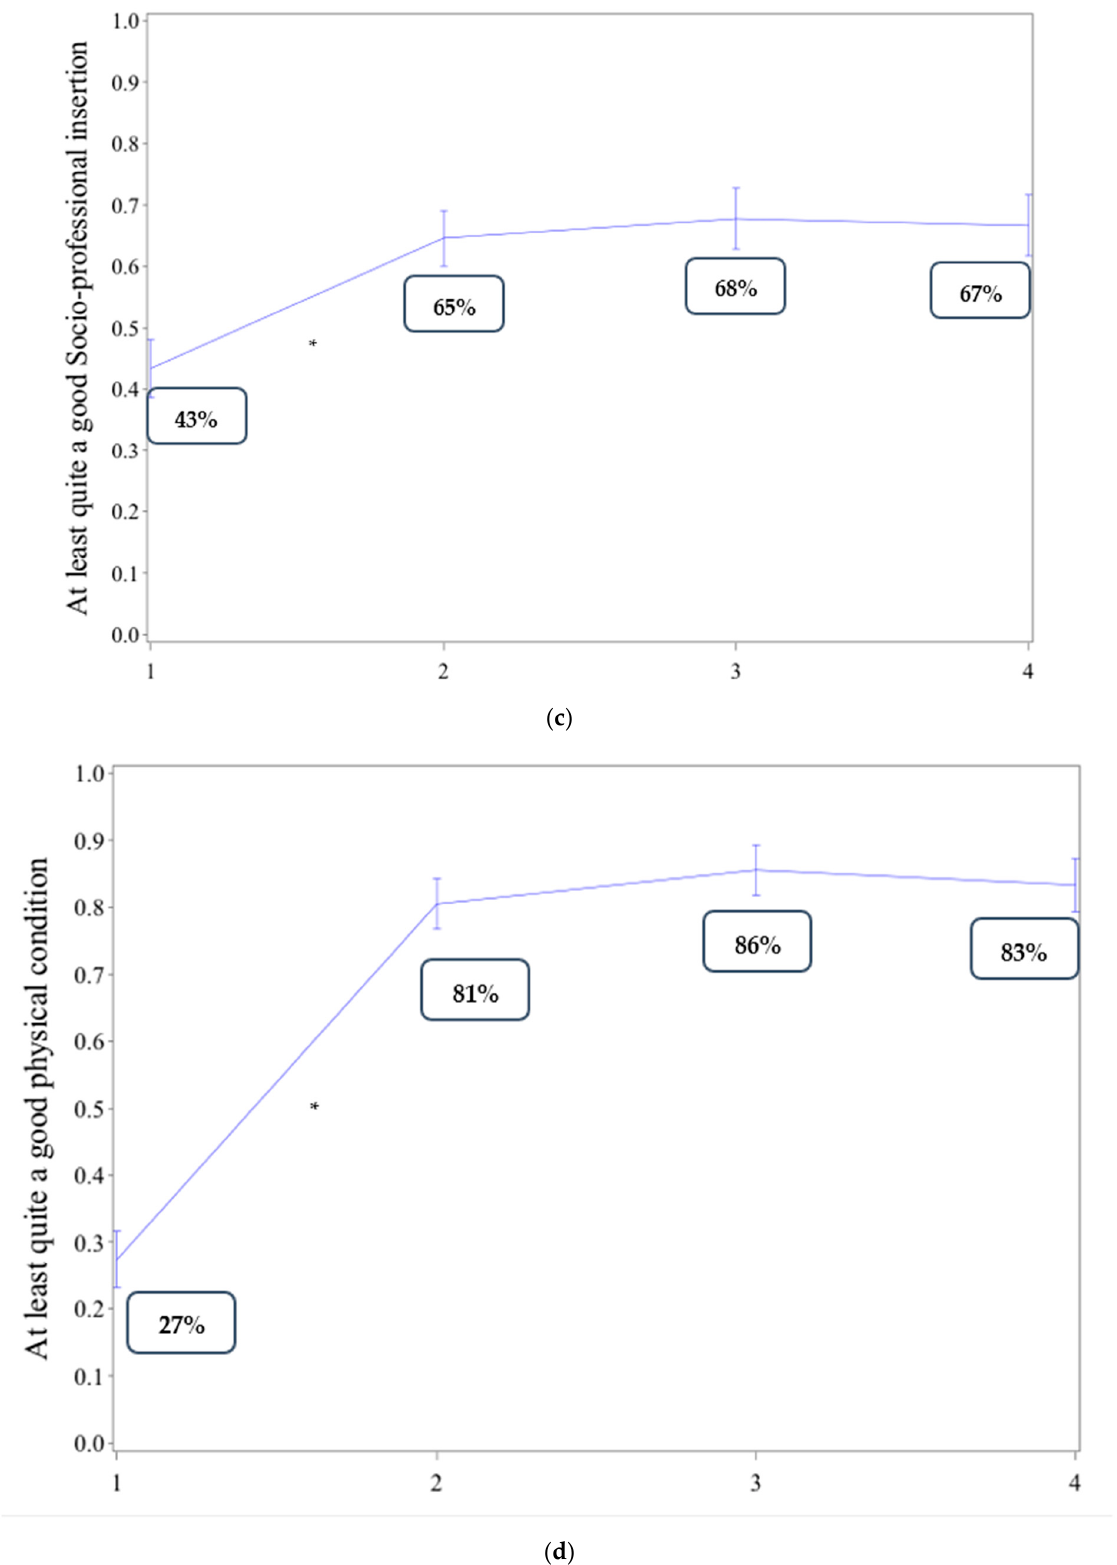
Figure 4. ( a ) Change in the proportion of patients whose QoL ratings for family relationship were at least “quite good”, at different times. ( b ) Change in the proportion of patients whose QoL ratings for psychological state were at least “quite good”, at different times. ( c ) Change in the proportion of patients whose QoL ratings for socio-professional insertion were at least “quite good”, at different times. ( d ). Change in the proportion of patients whose QoL ratings for physical condition were at least “quite good”, at different